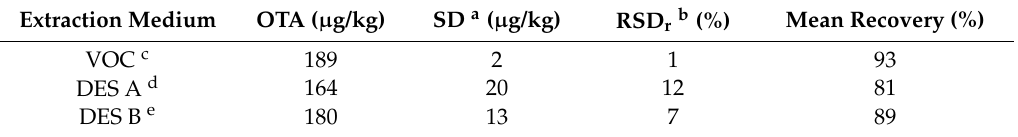
Table 1. Extraction of OTA with VOC and DES mixtures from durum wheat samples spiked at 203 µg/kg ( n = 3).